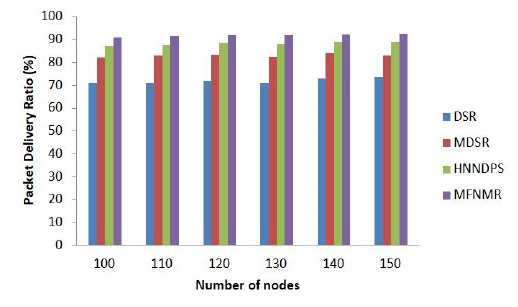
Figure 3. PDR Analysis based on Number of Nodes.